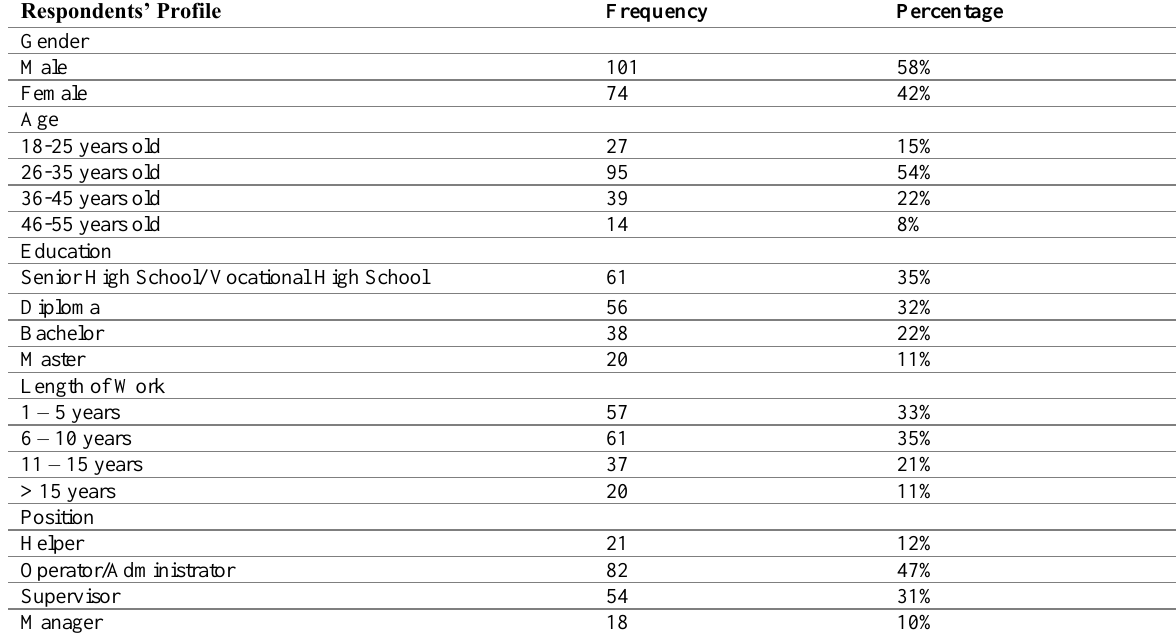
Table 1: Respondent Profile